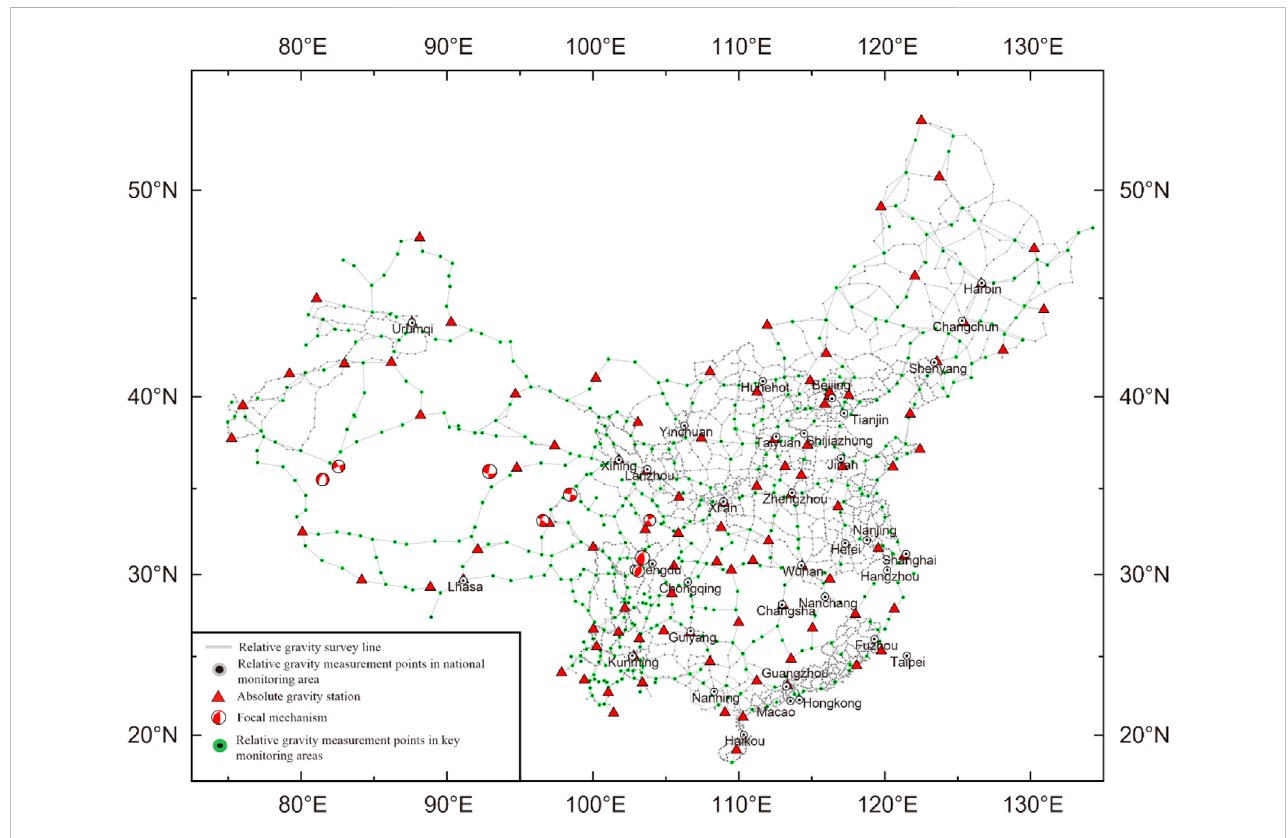
FIGURE 1 Seismic gravity monitoring network in the China continental